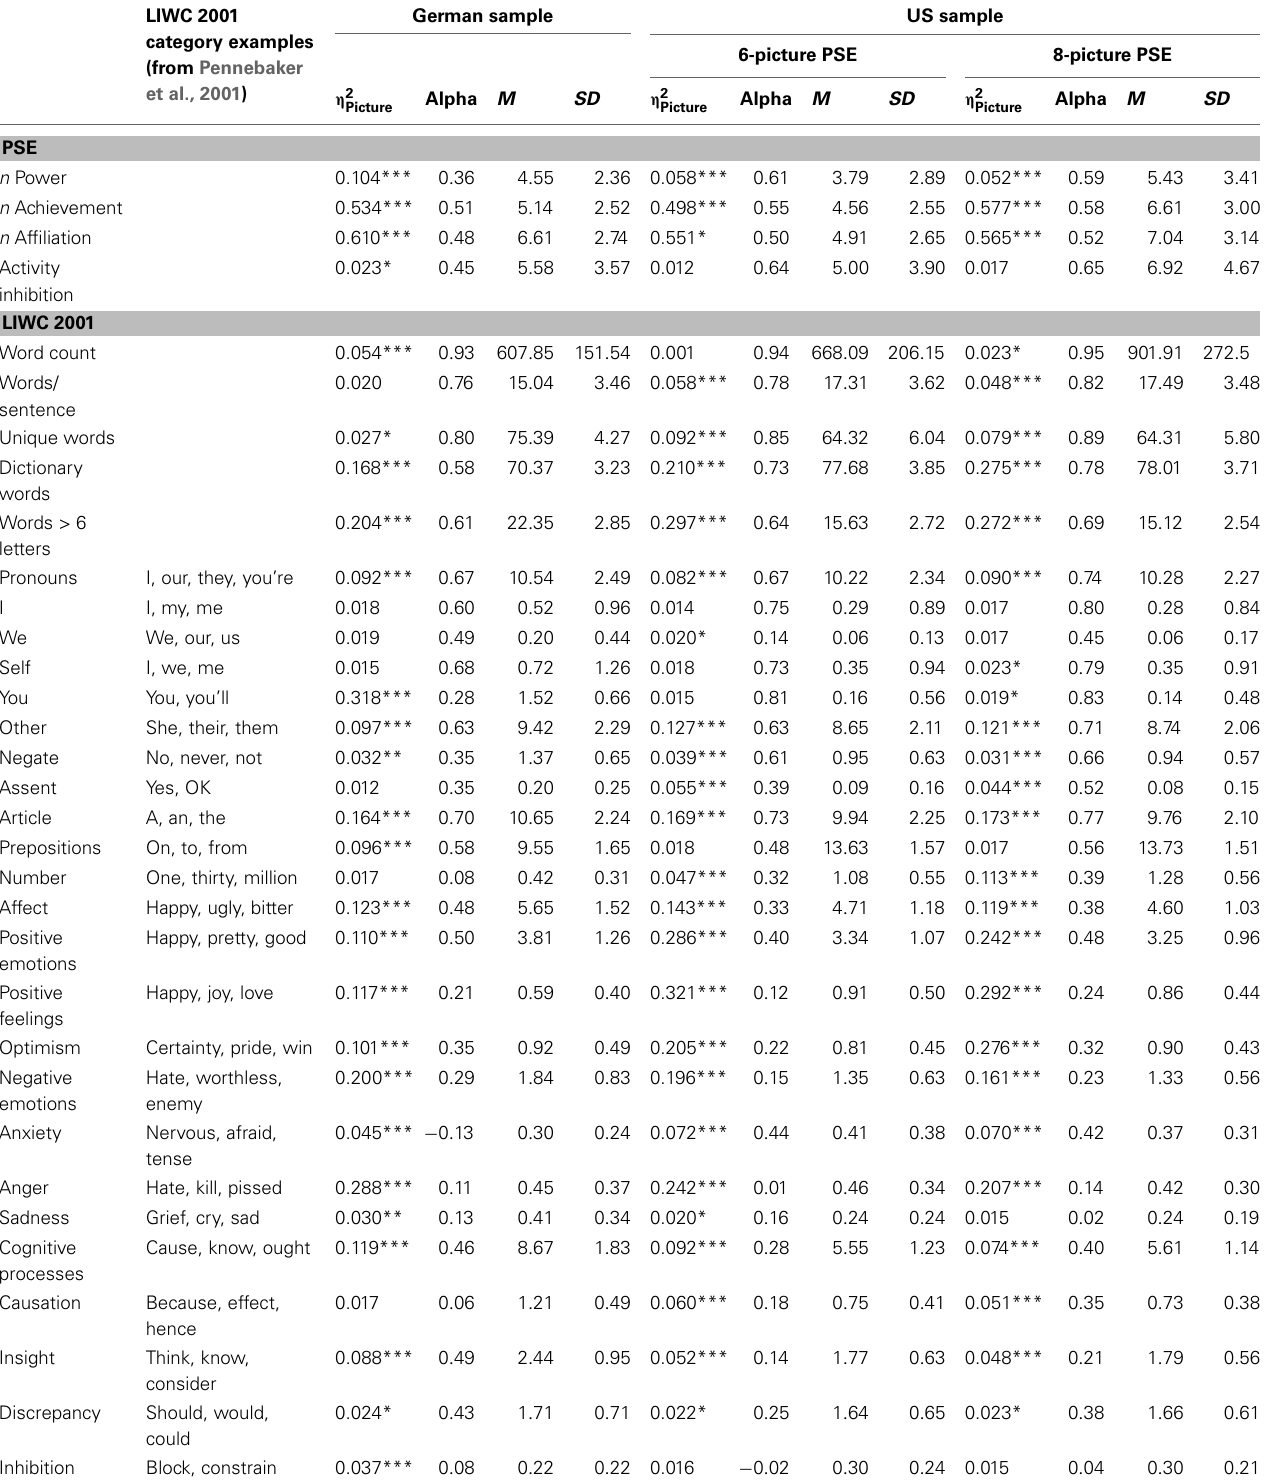
Table 1 | Descriptive statistics ( M, SD ), variance accounted for by picture cues ( η 2 stories (Cronbach’s alpha) for German (6-picture PSE) and US samples (6- and 8-picture PSEs) for content-coded raw motive scores and